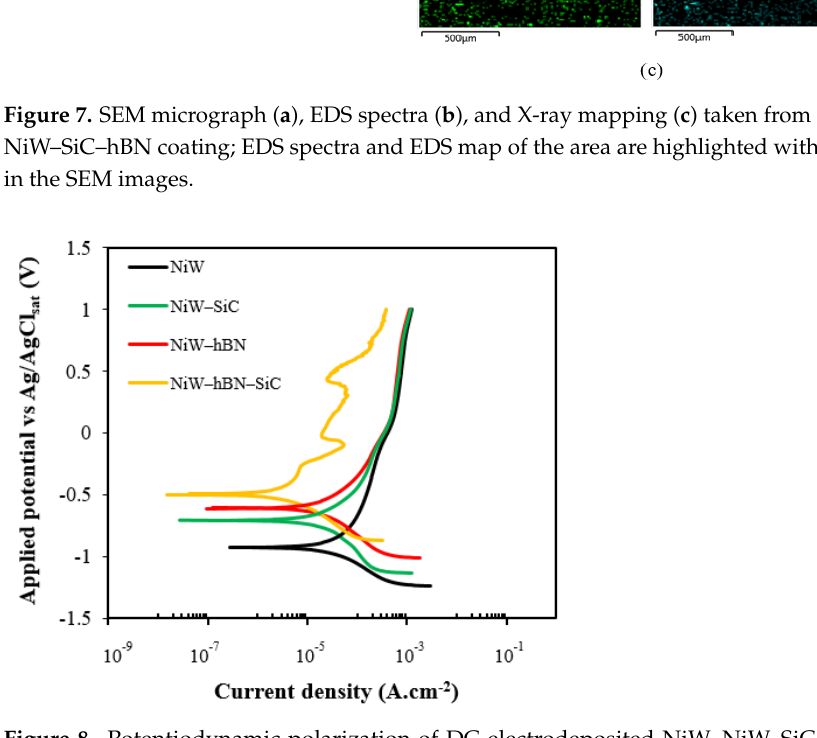
Figure 8. Potentiodynamic polarization of DC electrodeposited NiW, NiW–SiC, NiW–hBN, and NiW–hBN–SiC performed at room temperature ( ∼ 25 °C) and pH of ∼ 8. Table 3. Corrosion potential and current density values extracted from potentiodynamic polariza- tion graph.